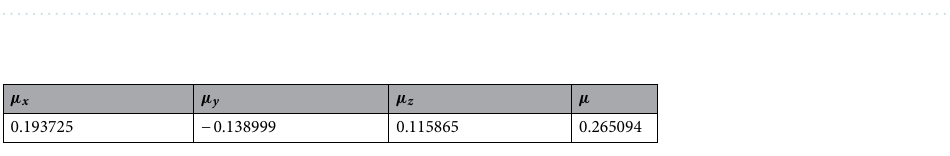
Table 3. The HOMO and LUMO energy, energy gap (eV), chemical potential (μ), chemical hardness (η), electronegativity ( ξ ), and electrophilicity (ω), (in eV) of Lycopene 39–41 .